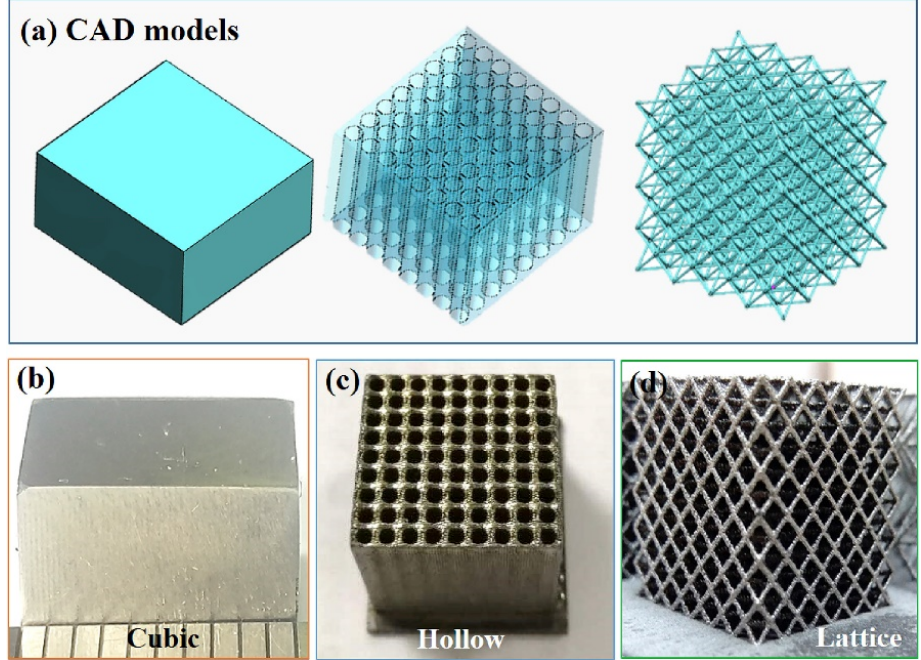
Figure 26. ( a ) CAD models and ( b – d ) fabricated parts of a Zr-based BMG via LPBF. Reproduced from [36], with permission from Elsevier, 2021.